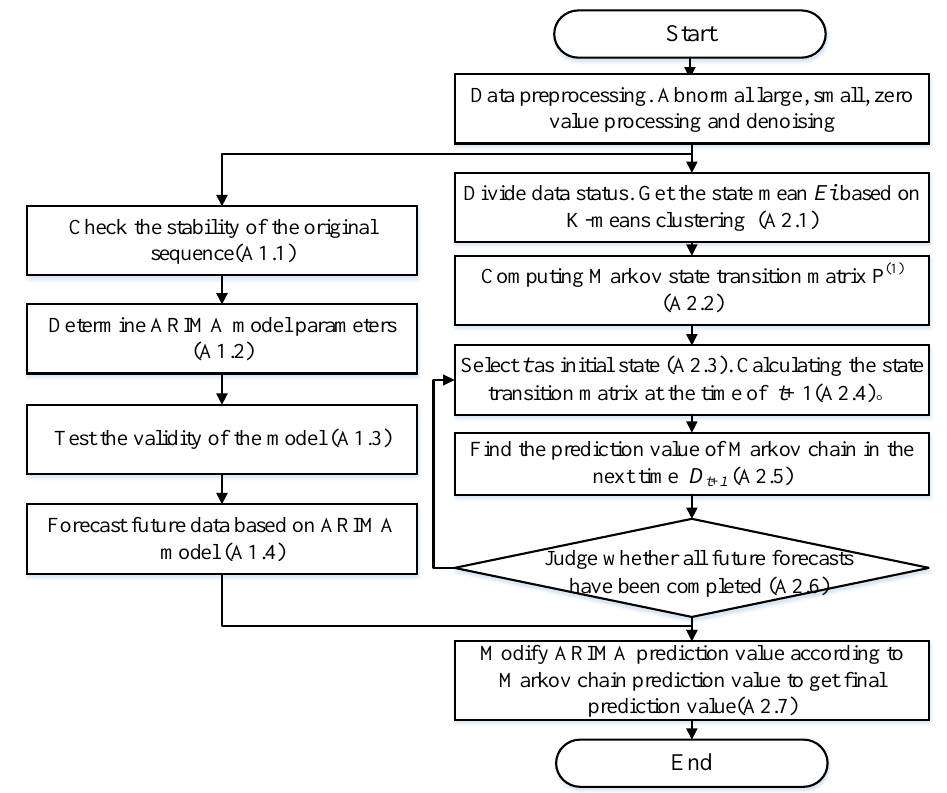
Figure 1. Flow chart of water consumption forecast based on Markov chain correction.